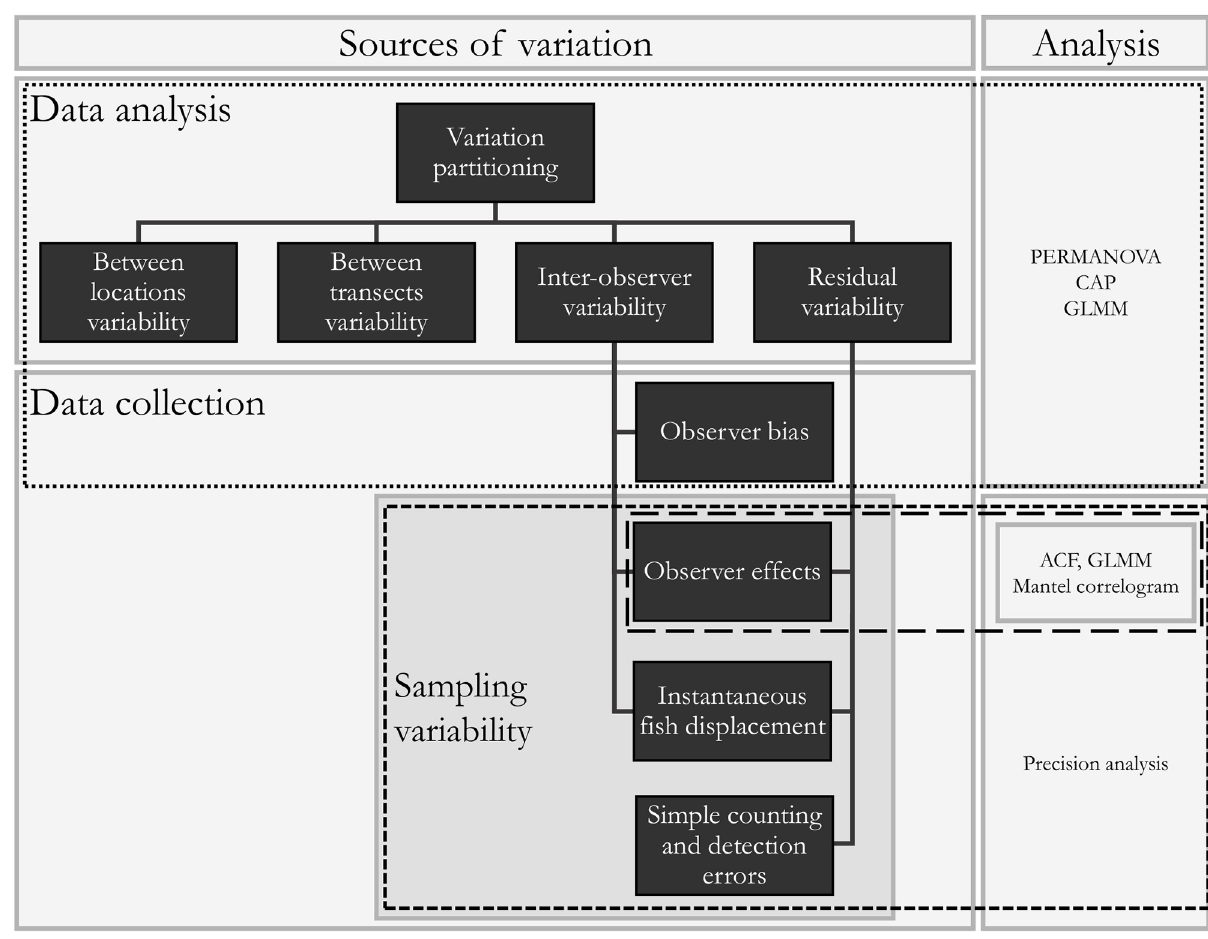
Fig 2. Methodological framework of the study. Variation partitioning using PERMANOVA (permutational multivariate analysis of variance), CAP (canonical analysis of principal components), and GLMM (generalized linear mixed models) to quantify the different sources of variation for multivariate and univariate data respectively. The modeled inter-observer variability not only comprises the observer bias, but also sampling variability, i.e. observer effects and instantaneous fish displacement. The residual variability comprises the remaining sampling variability. ACF (auto-correlation functions), GLMM and partial Mantel correlograms to assess observer effects. Precision analysis was used to assess the effect of number of repeats and transect length on quantification and reduction of sampling variability.